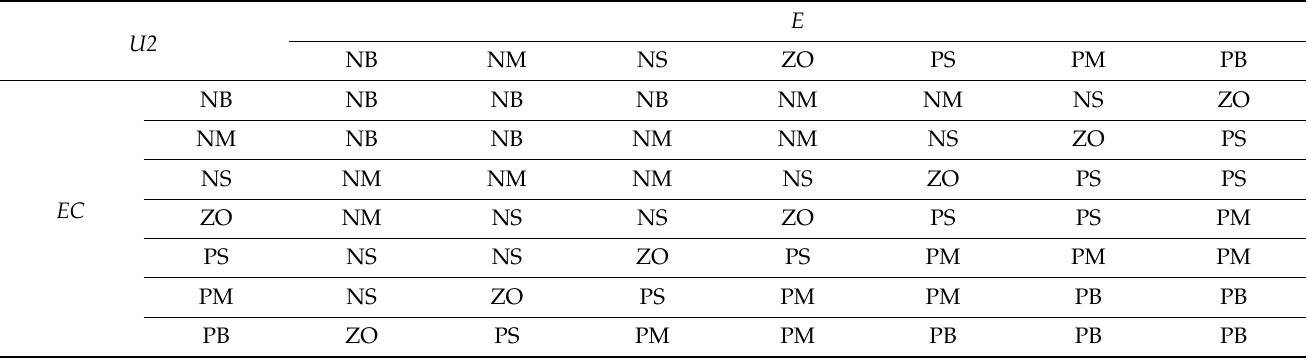
Table 2. Fuzzy rule base of U2 .